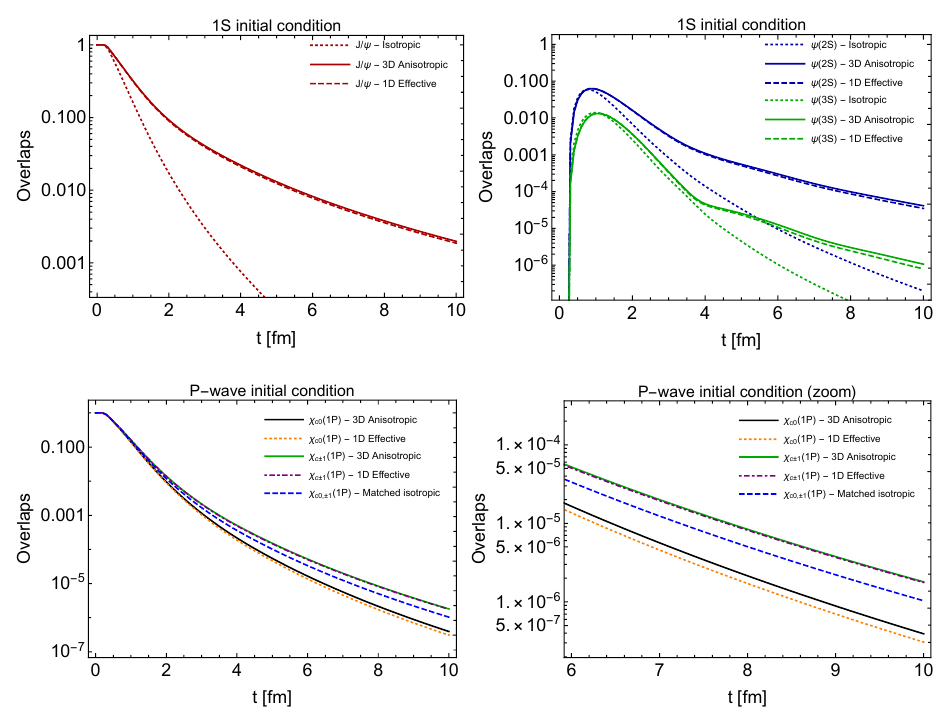
Figure 2. The top row shows the overlaps of J /ψ , ψ (2 S ), and ψ (3 S ) resulting from real-time solution of the Schrödinger equation. Here we initialized the wave function as pure J /ψ eigenstate. The bottom row shows the time evolution of the charmonium p-wave overlaps resulting from initialization with di ff erent p-wave polarizations